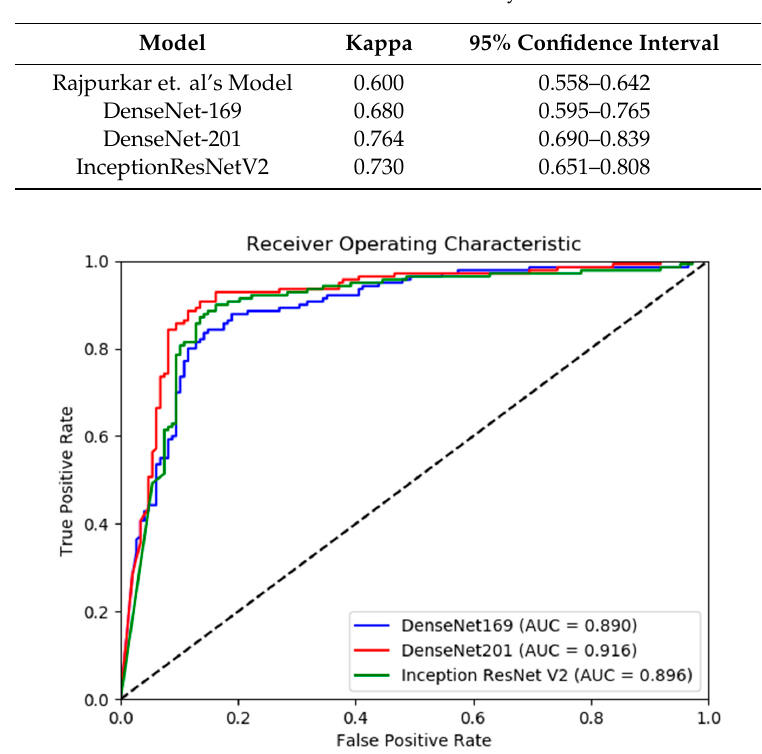
Figure 4. Model Receiver Operating Characteristic Curves—Humerus.